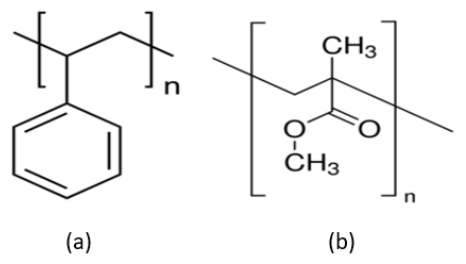
Figure 8. Monomer of ( a ) polystyrene and ( b ) polymethyl methacrylate.